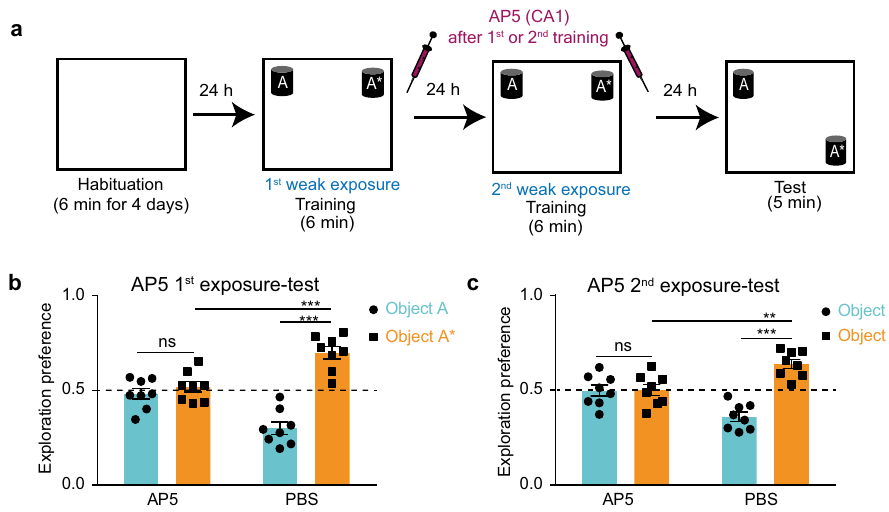
Fig. 5 Long-term storage and activation of STM trace is N-methyl-D-aspartate receptor-dependent. a NOL two-training paradigm with 1-day interval in between with AP5 injection after either the fi rst or the second training sessions into the CA1 region. Exploration preference for each object during the test session for groups injected after the fi rst ( b ) or the second ( c ) training sessions for AP5- ( n = 8) and PBS- ( n = 8) injected groups. Comparisons were made using paired student ’ s t-test for comparing object A and object A* in the same group, and unpaired student ’ s t-test for comparing object A* within different groups; ns, not signi fi cant ( P > 0.05), ** P < 0.01, *** P < 0.001. Data are presented as the mean ±